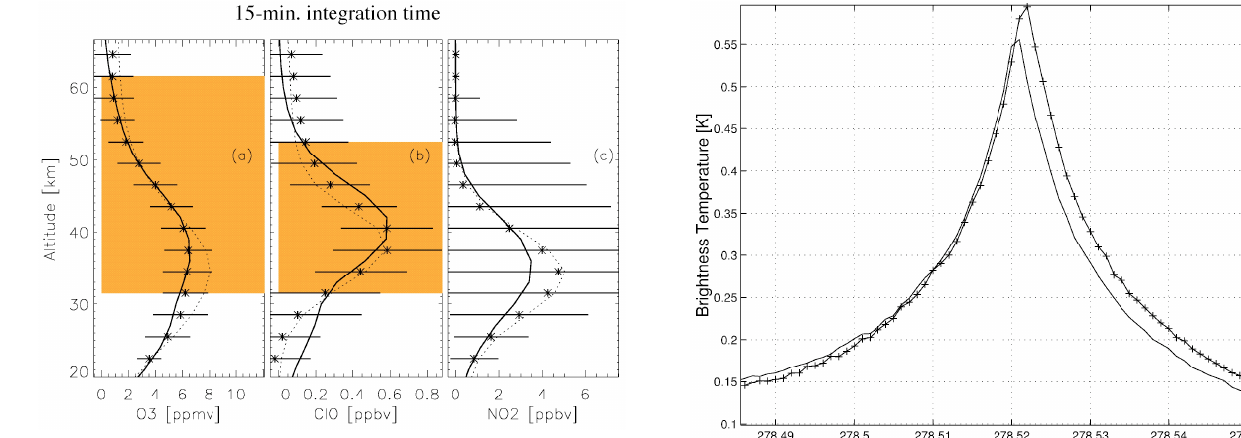
Fig. 10. Ozone line measured in January 1995 (solid line) and in March 1995